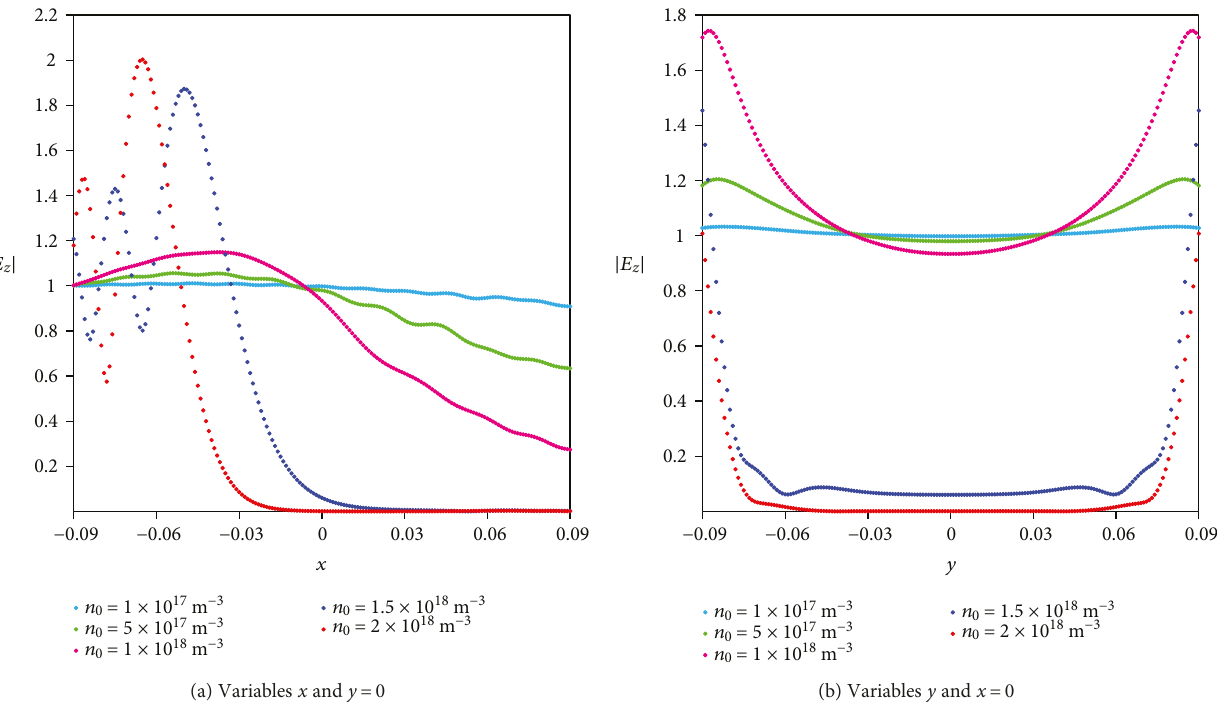
Figure 18: Magnitude of the electric fi eld, in volts/meter, inside the plasma for linear cuts through the cylinder obtained by the FDTD simulation for di ff erent central electron densities n to ν =500 × 10 6